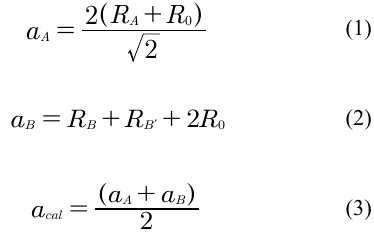
Table. 1XRD data of Ba